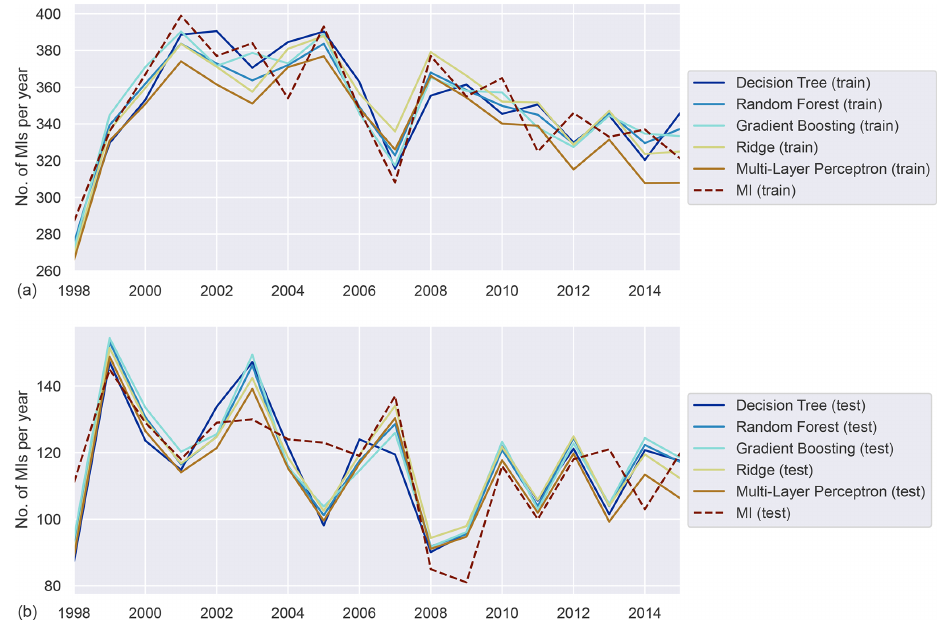
Figure A1. Annually aggregated predictions of MI in the urban population for all models. Predicted (solid) and observed MI (dashed) for training (a) and test (b) sets.